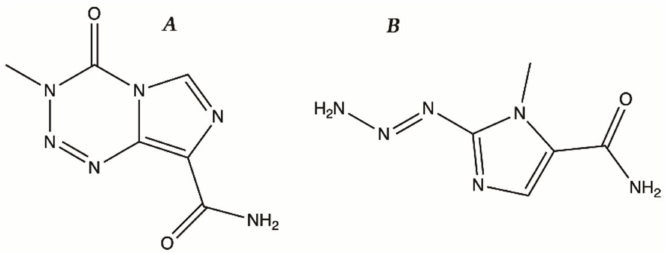
Figure 1. ( A )—Temozolomide (TMZ); ( B )—3-methyl-(triazen-1-yl)imidazole-4-carboxamide